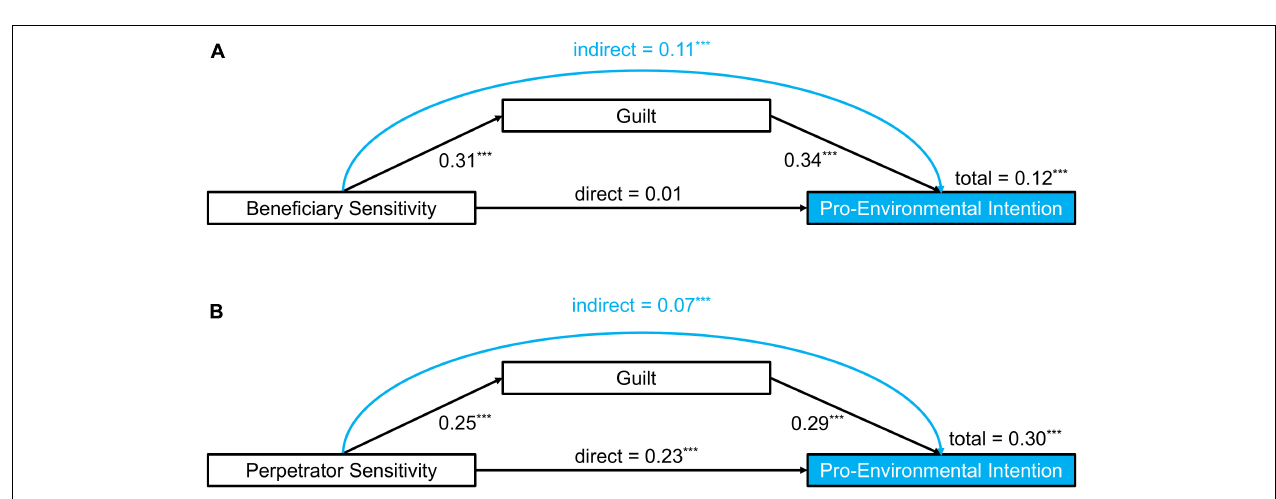
FIGURE 2 | Regression weights of the final model of pro-environmental intention after backward elimination. This final model significantly predicted pro-environmental intention, F (7, 872) = 54.41, p < 0.001, with a large effect size, R 2 = 0.30 (adjusted R 2 = 0.29). * p < 0.05, *** p < 0.001; coefficients are standardized regression